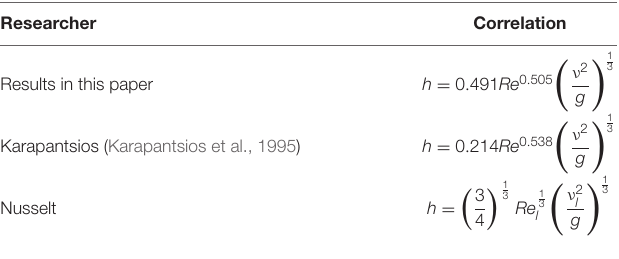
TABLE 1 | Correlations of average liquid film